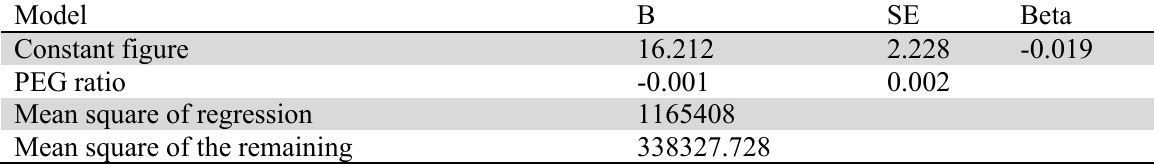
Estimation of the simple linear regression between PEG and stock returns Model